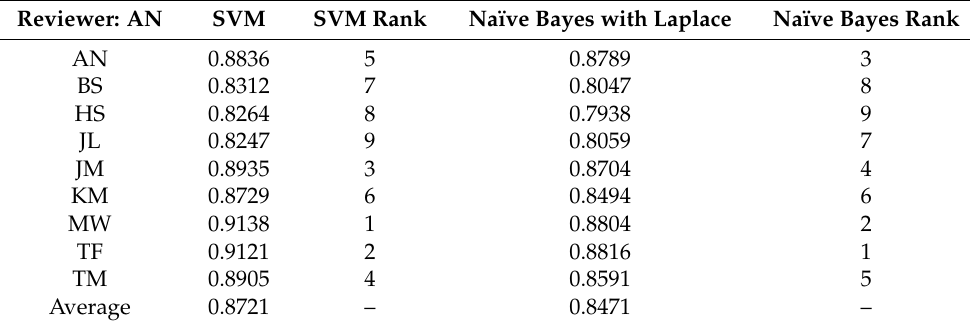
Table 9. Comparison results obtained from SVM and Naïve